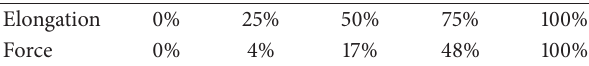
Table 1: Five points representing “J”